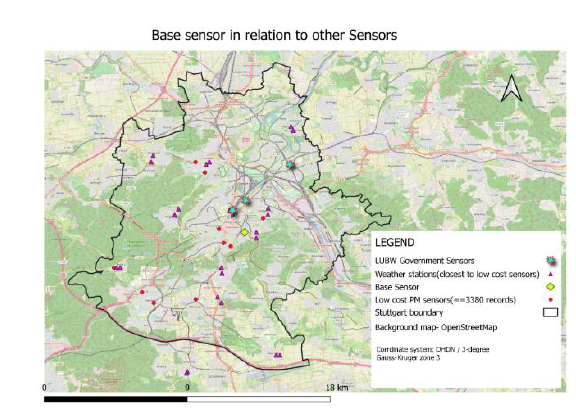
Figure 7. Base sensor location